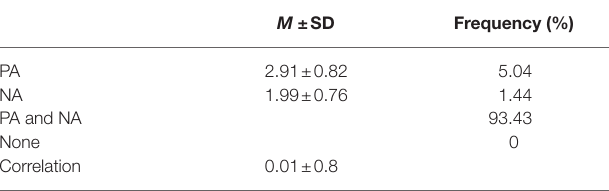
TABLE 2 | Descriptive statistics of the emotional records in study